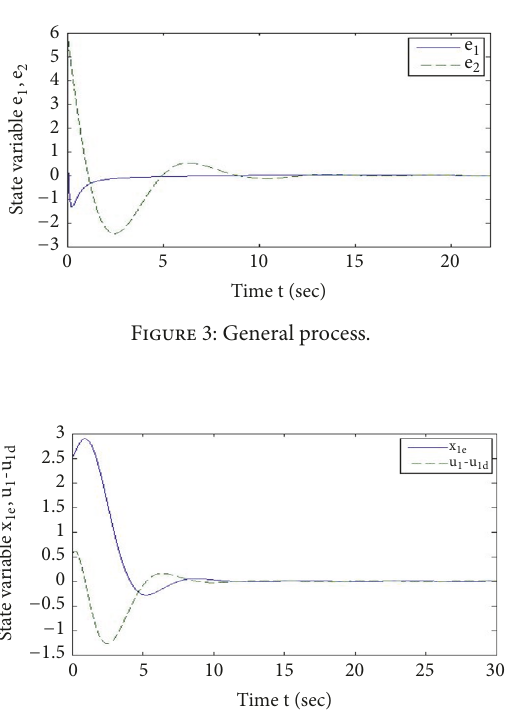
Figure 4: The response of state variable ( 𝑥 1𝑒 , 𝑢 1 − 𝑢 1𝑑 ) with respect to